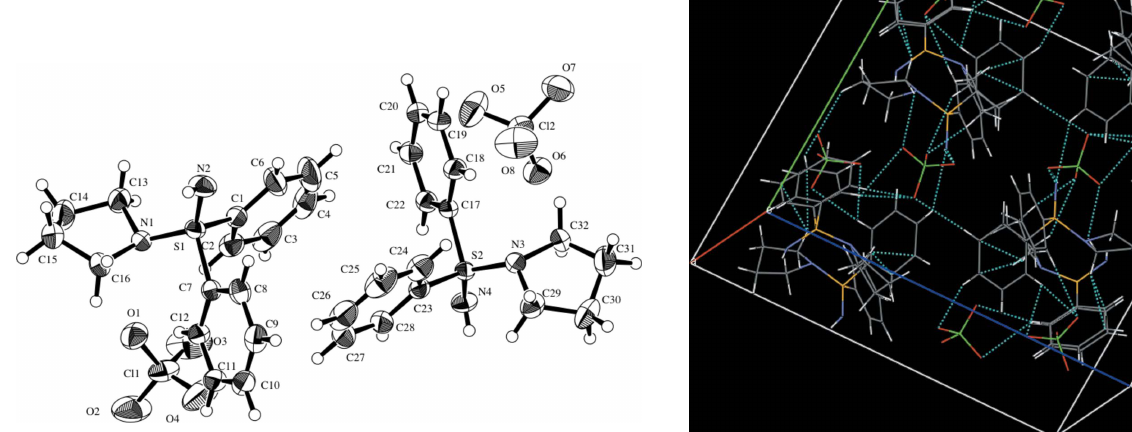
Figure 1 The asymmetric unit of the title compound, showing the atom-labelling scheme. Displacement ellipsoids are drawn at the 50% probability